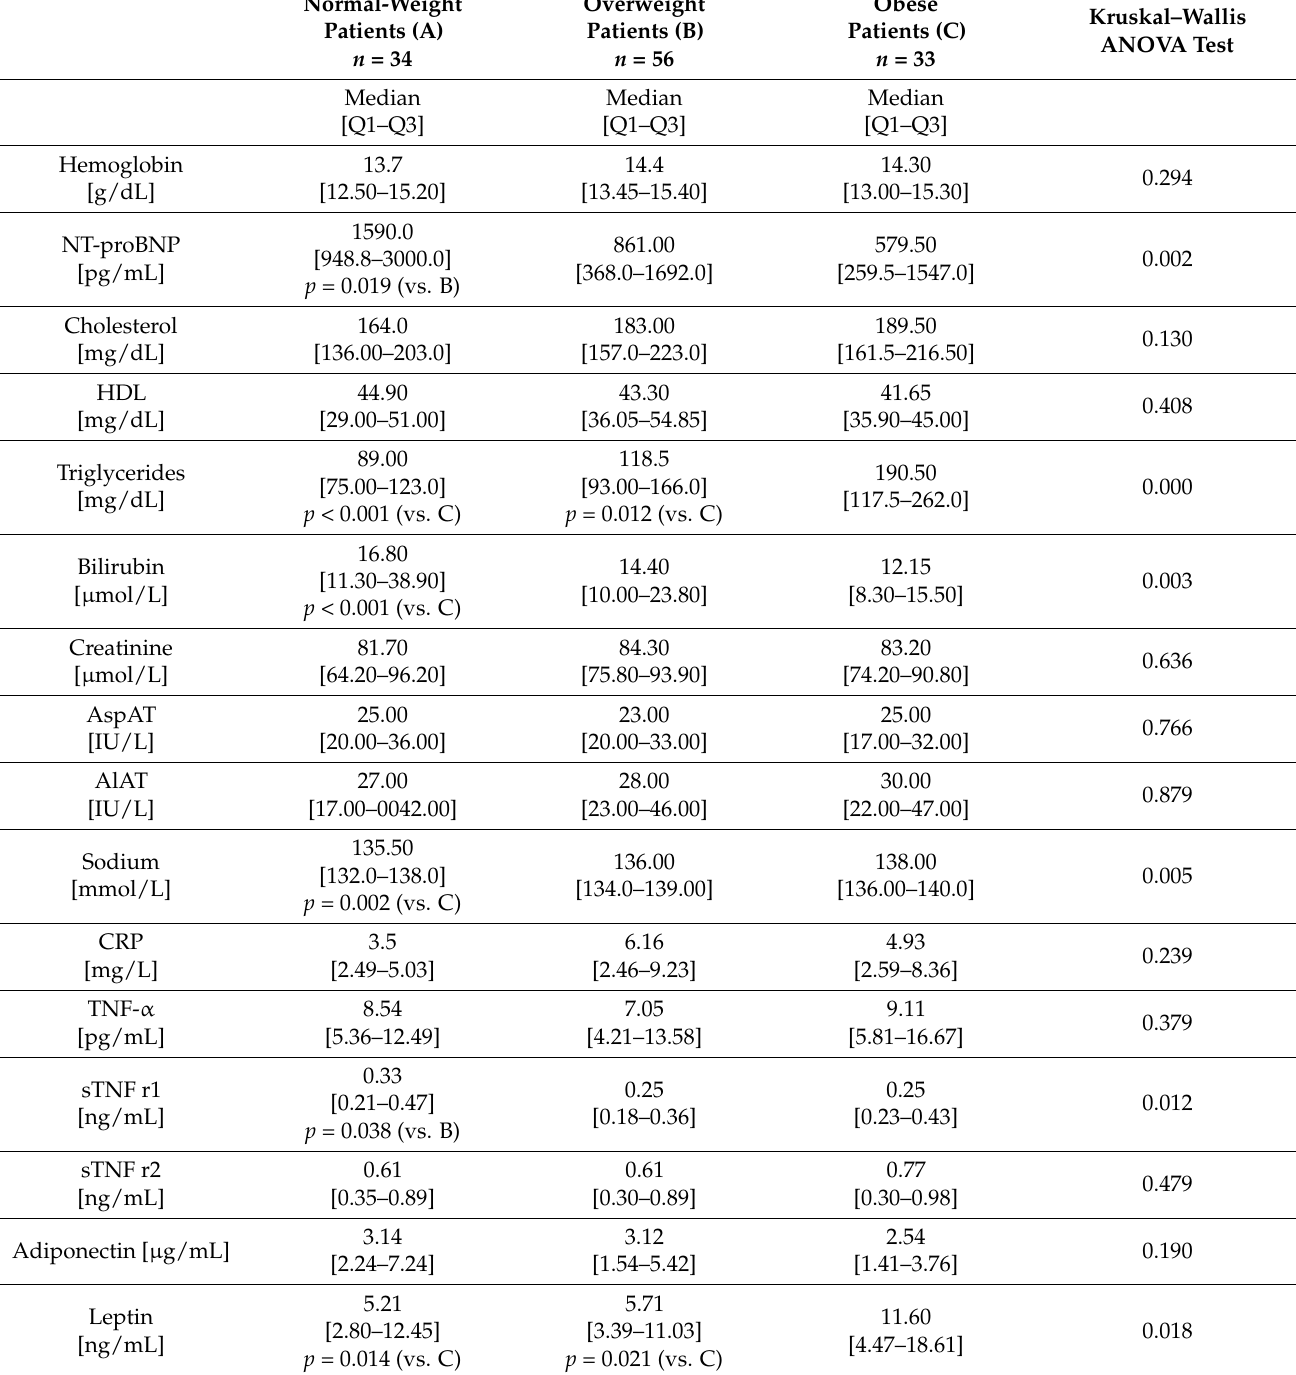
Table 2. Basic laboratory parameters and inflammatory biomarkers divided according to